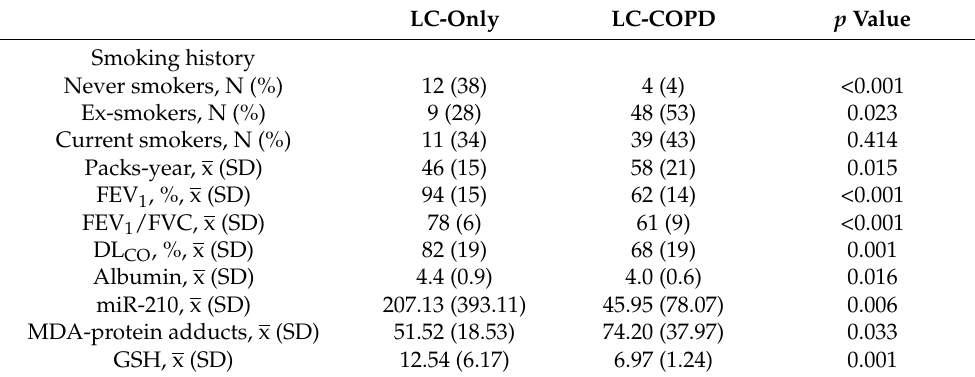
Table 3. Bivariate analysis of clinical and biological variables in patients with LC with and without COPD.